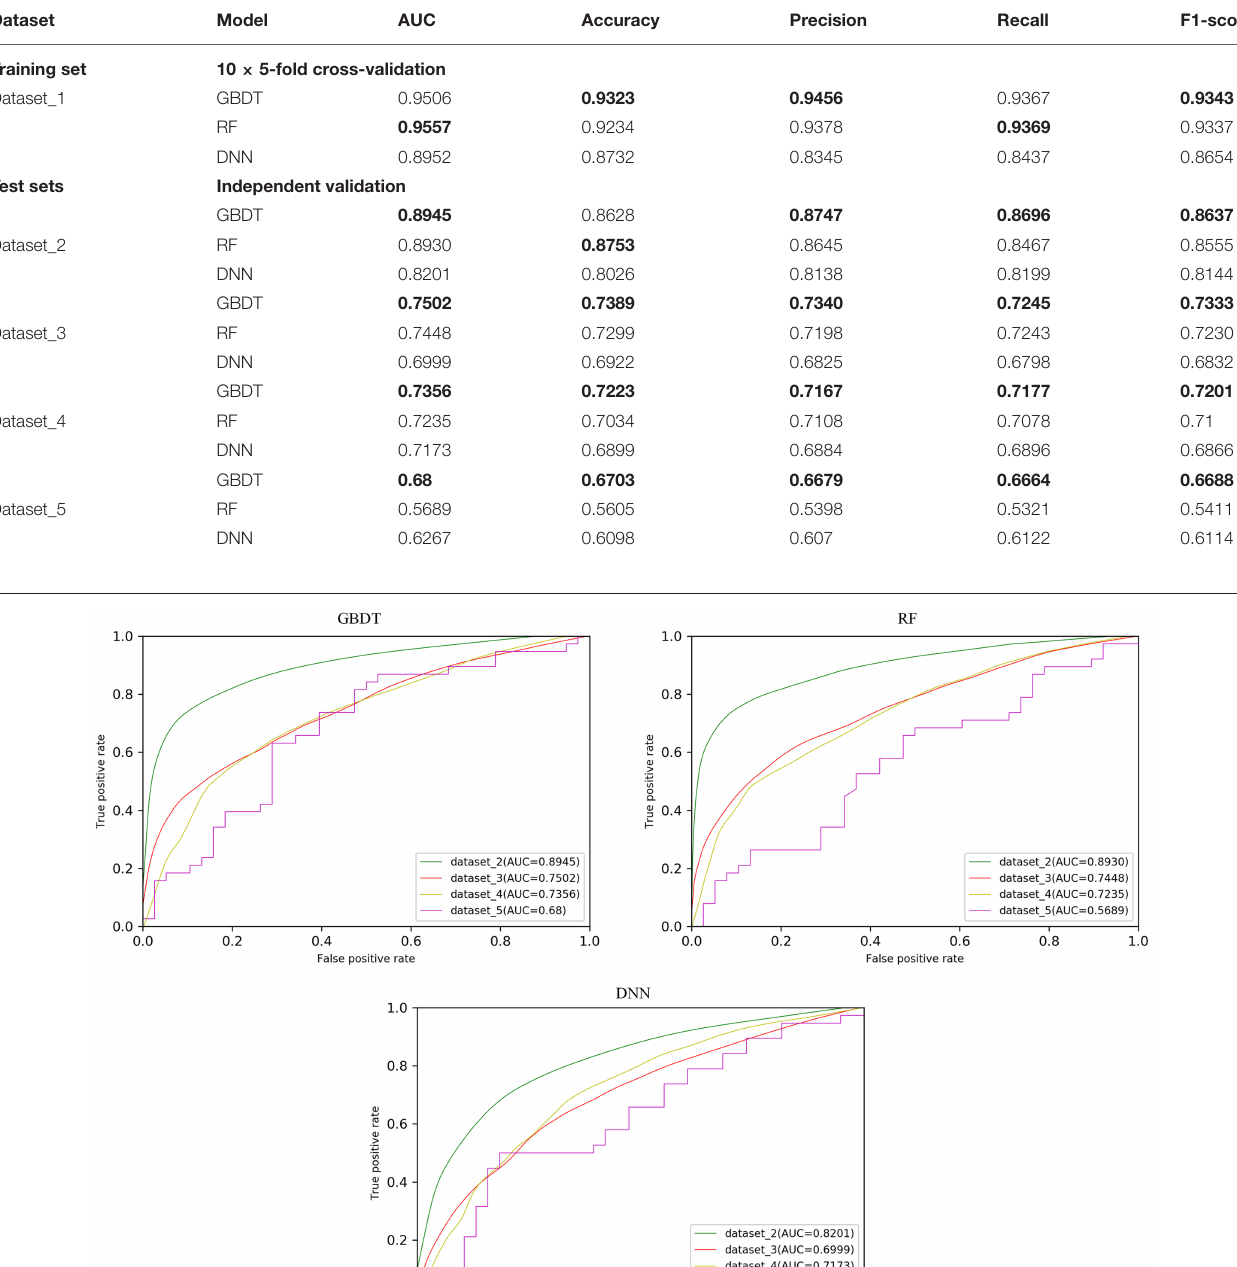
TABLE 4 | Results of classification performance using three classifiers on datasets obtained from DrugBank, with the highest scores highlighted in the bold font.